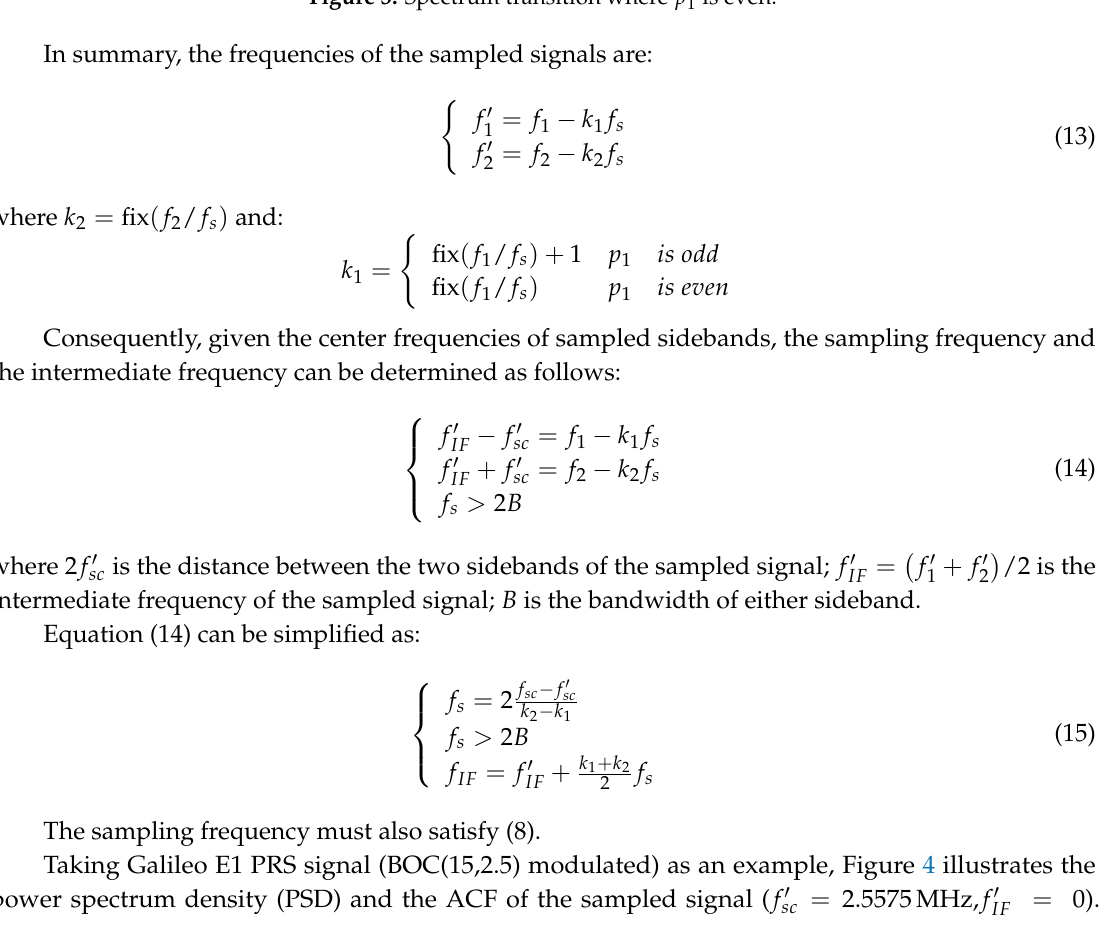
Figure 3. Spectrum transition where p 1 is